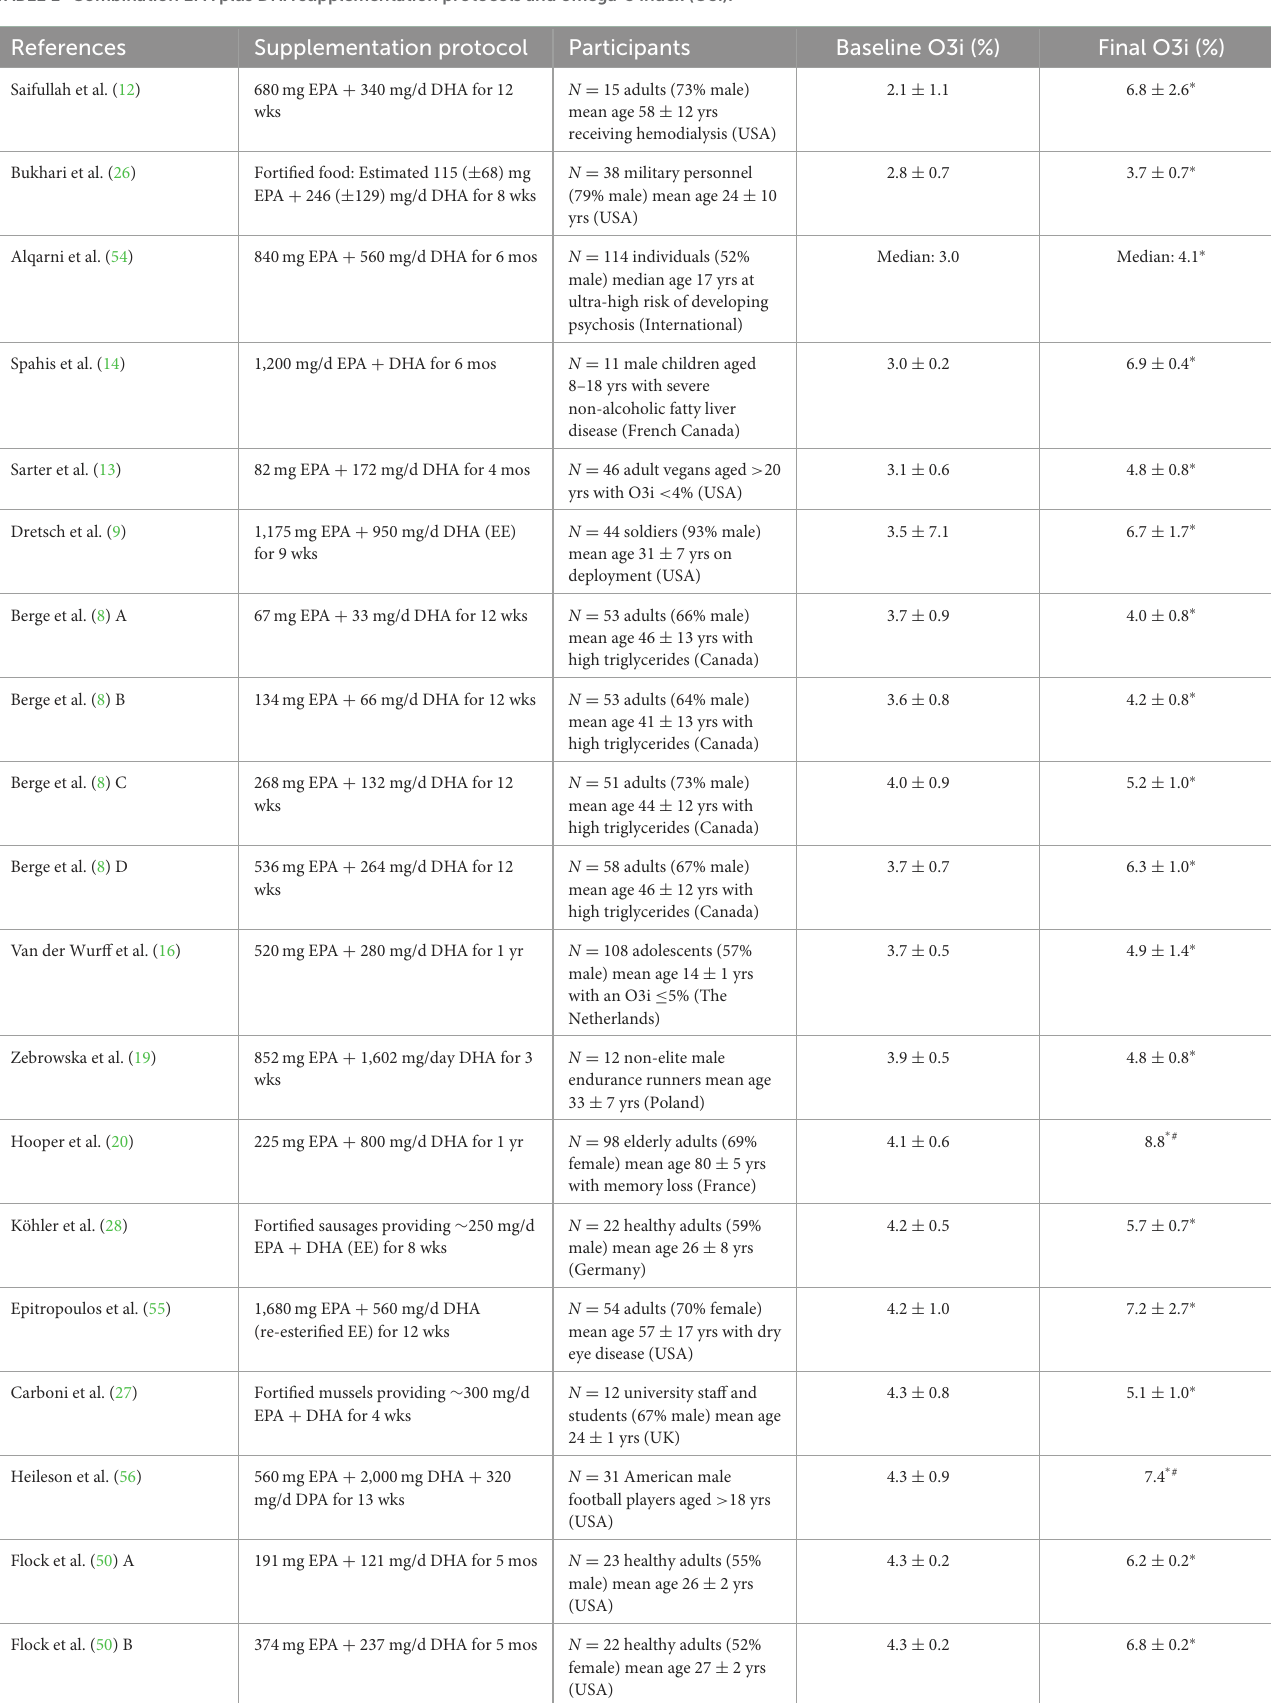
TABLE 1 Combination EPA plus DHA supplementation protocols and omega-3 index